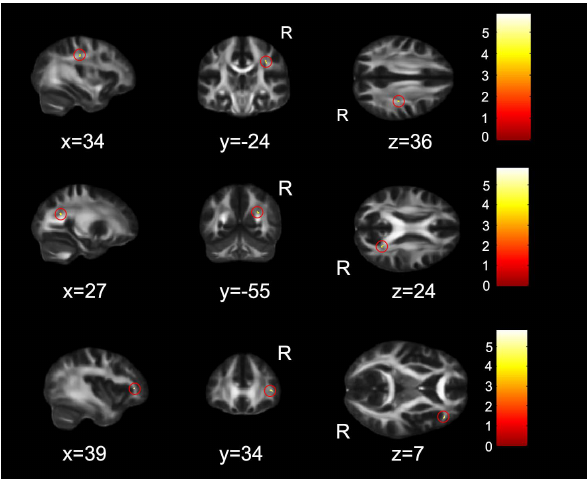
Figure 5. Group probability map generated from the alerting- related region. The red-yellow region was identified as cerebellotha- lamic tract. The green cluster was the seed mask located in the Crus I.